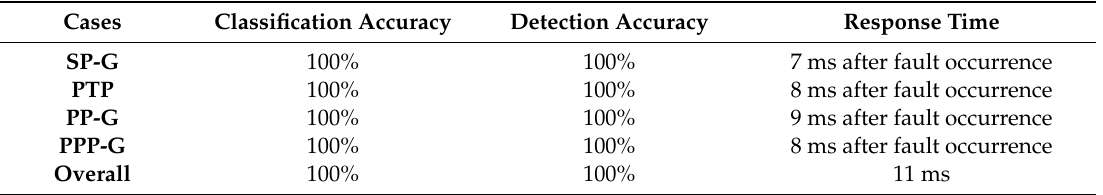
Table 4. Classification results of di ff erent types of events.